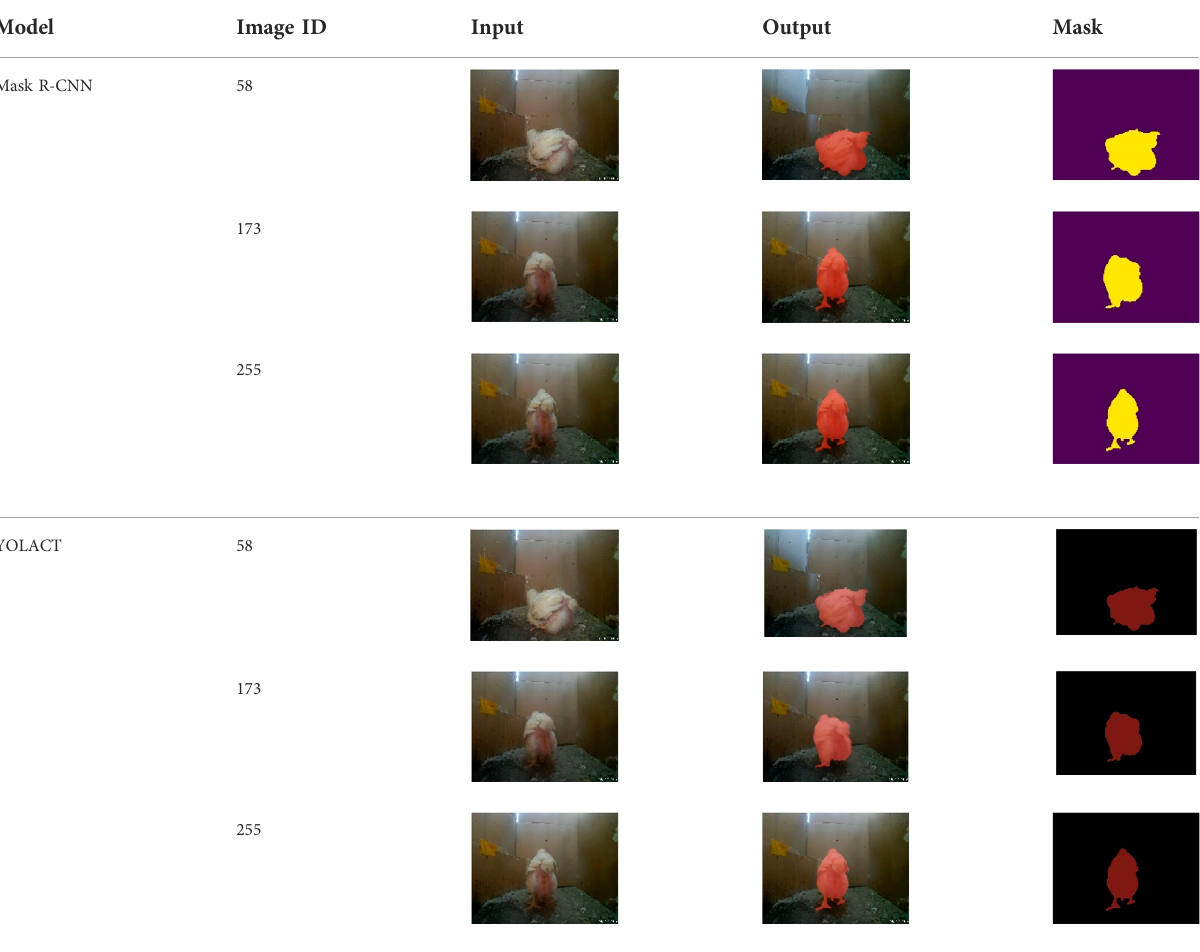
TABLE 2 The semantic segmentation algorithm